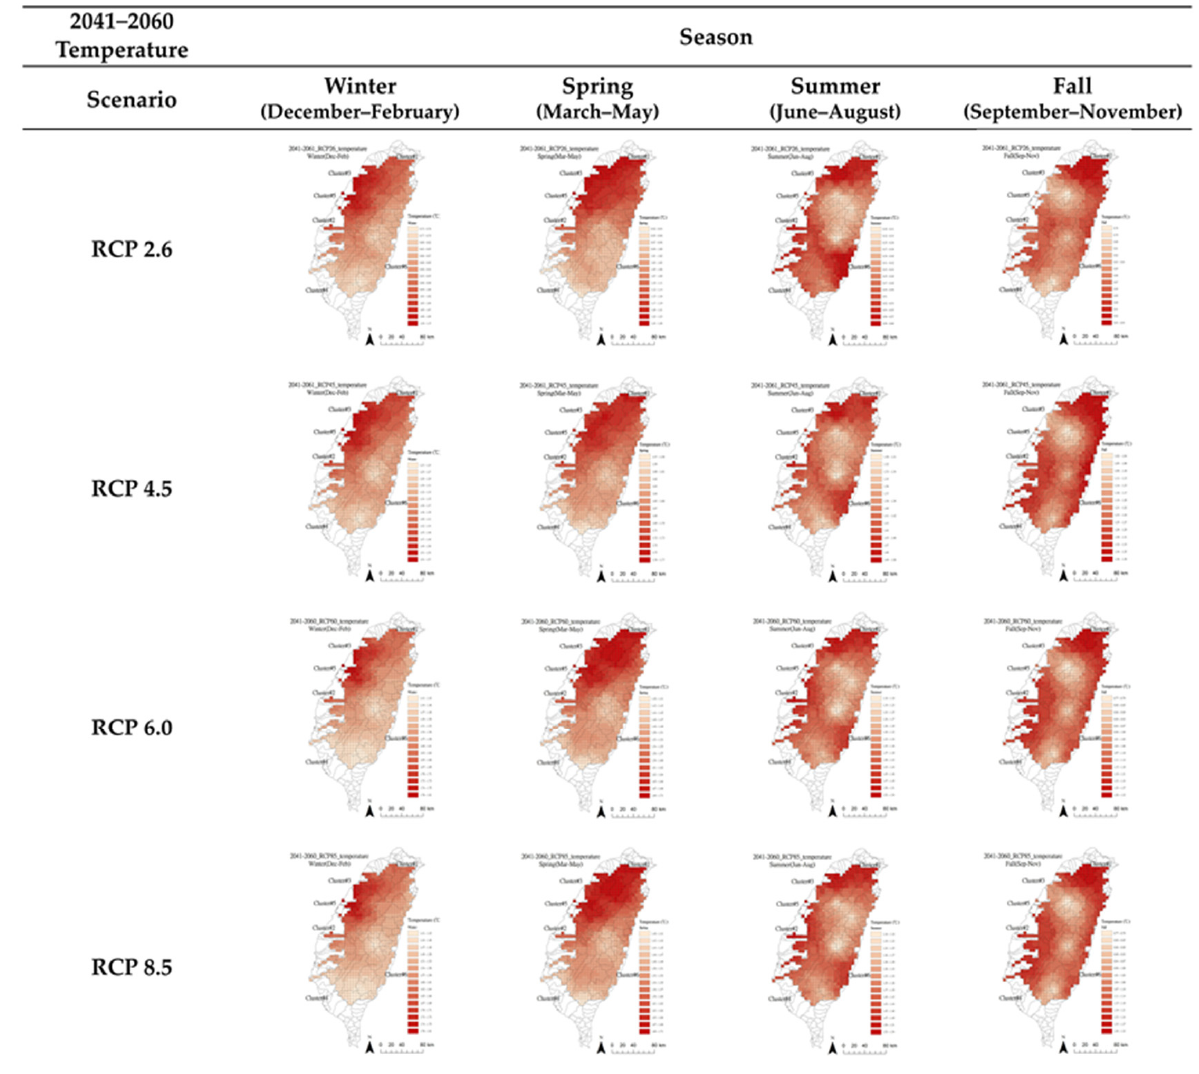
Figure A10. Spatial distribution of simulated temperature data from 2041–2060 for four seasons under different climate change scenarios.